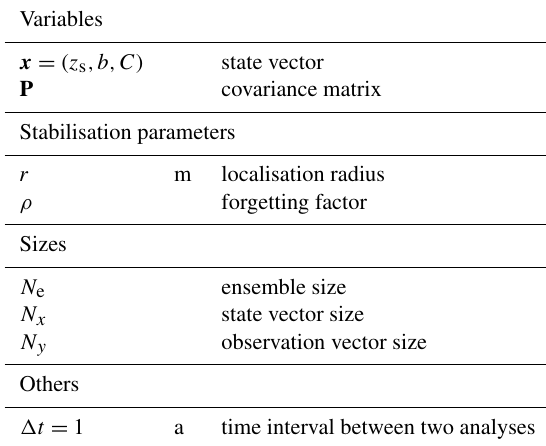
Table A2. Notations and values used in this study associated with the ensemble